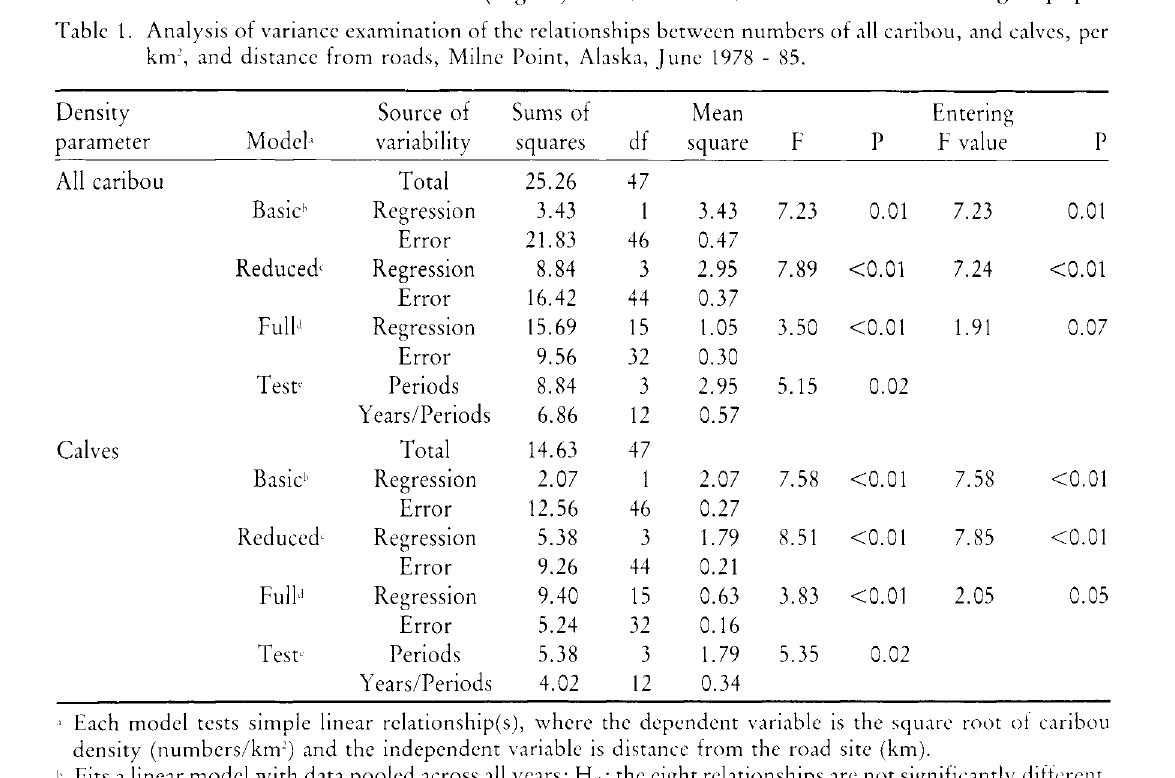
Table 1. Analysis of variance examination of the relationships between numbers of all caribou, and calves km 2 , and distance from roads, Milne Point, Alaska, June 1978 -